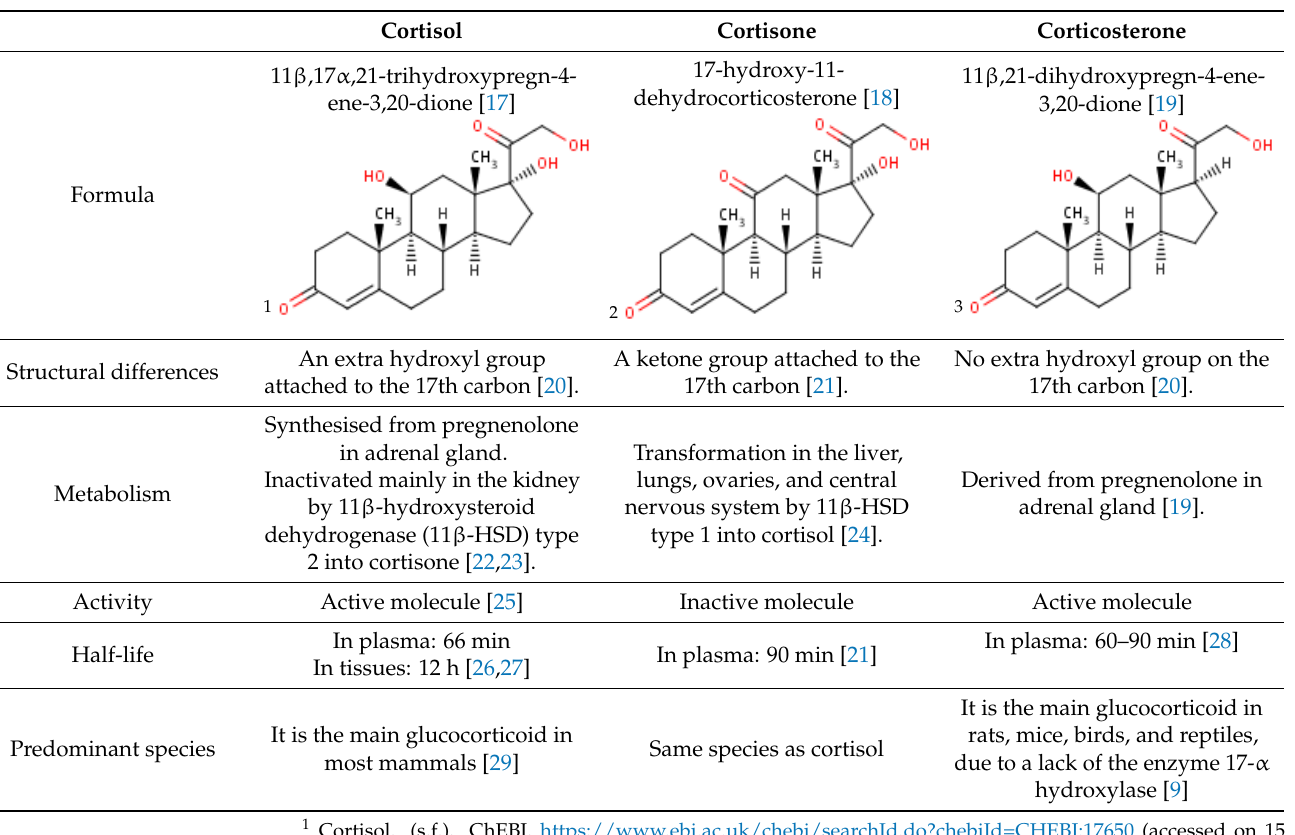
Table 1. Main glucocorticoids and their main characteristics.